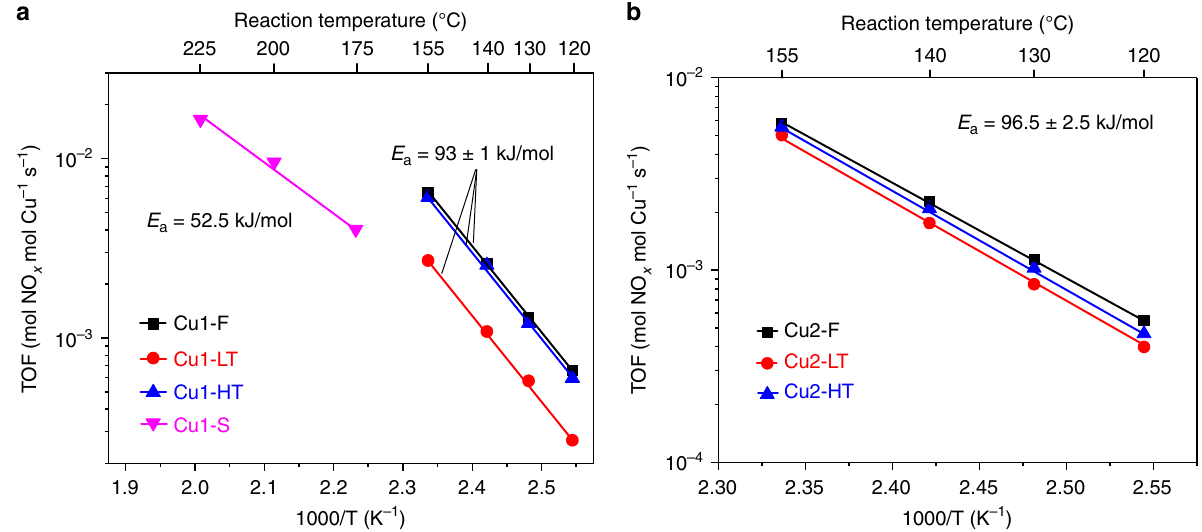
Fig. 1 Arrhenius plots for low-temperature standard NH 3 -SCR. a Cu1-F/LT/HT catalysts; b Cu2-F/LT/HT catalysts. The feed gas contained 360 ppm NO, 360 ppm NH 3 , 14% O 2 , 2.5% H 2 O and balance N 2 . The total gas fl ow was 1000 sccm, and the gas hourly space velocity (GHSV) was estimated to be ~650,000h − 1 . TOFs were calculated using EPR active Cu(II) contents in each